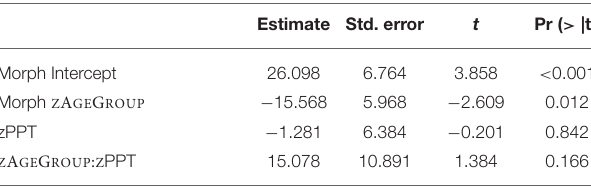
TABLE 6 | Lmer model for morphological priming with fixed effects of Z A GE G ROUP and Z PPT , as well as their interaction. Estimate Std. error Pr ( > |t|)